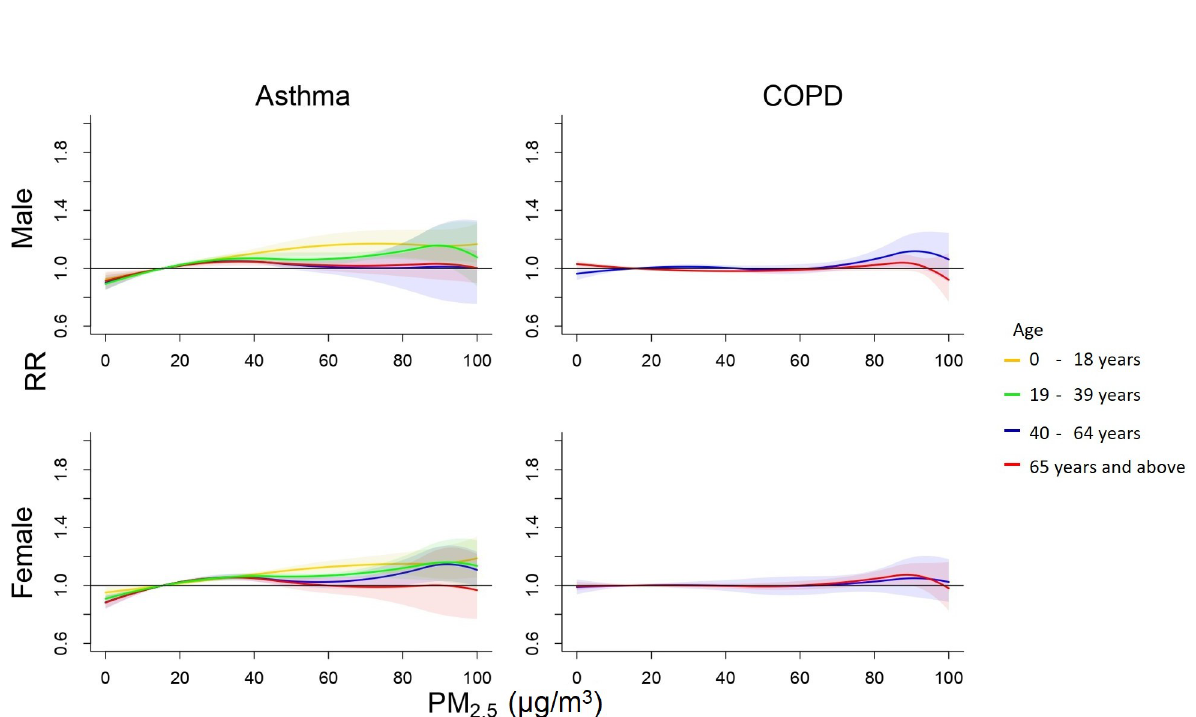
Fig 5. Cumulative 6-day (lag 0–5) relative risk (95% confidence interval) of outpatient visits for asthma associated with daily PM 2.5 level relative to Q1 level (17 μ g/m 3 ) after adjusting for daily average temperature.